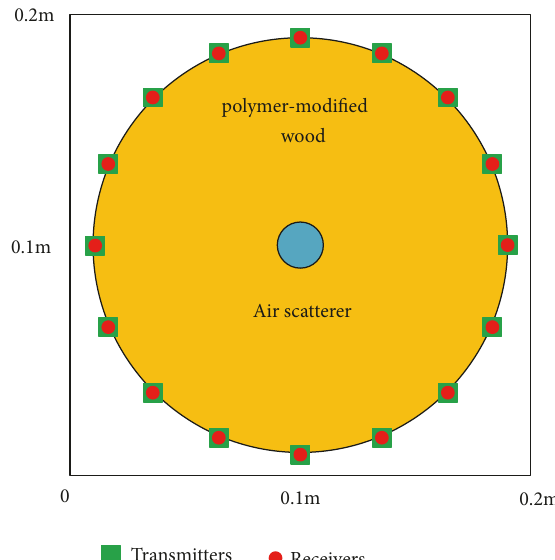
Figure 2: Single circular air defect model diagram.